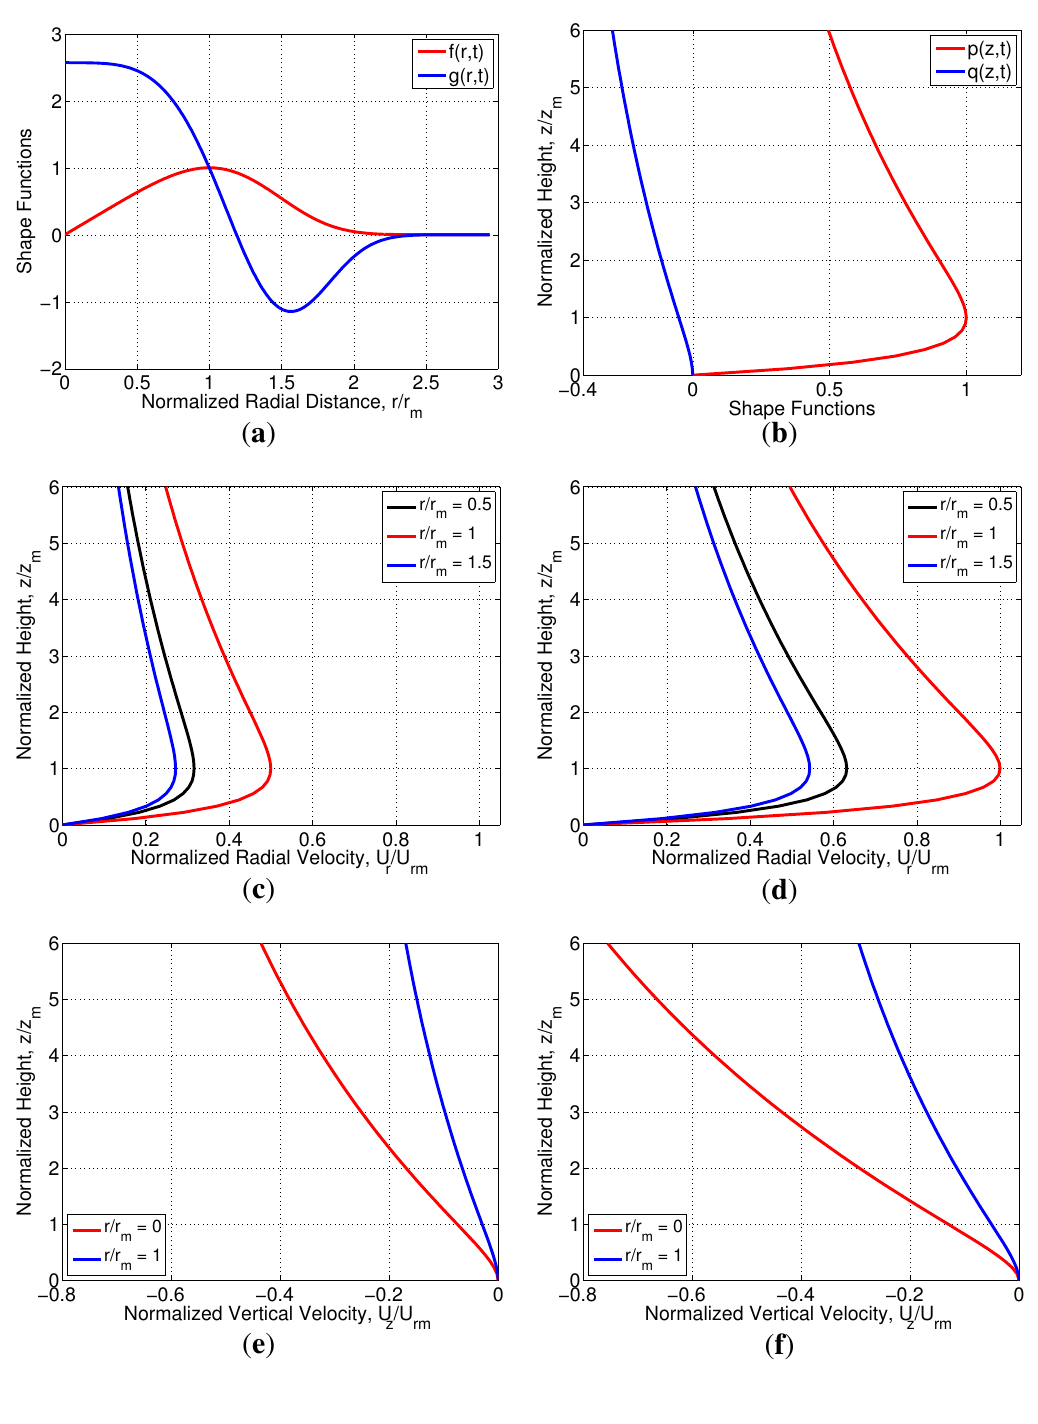
Figure 1. Non-turbulent mean winds: Shape functions and velocity profiles. ( a ) Shape functions for variation of the non-turbulent (mean) wind field with radial distance; ( b ) Shape functions for variation of the non-turbulent (mean) wind field with elevation; ( c ) Non-turbulent radial wind velocity profile when storm intensity, Π( t ) = 0 . 5 , i.e. , t = t / 6 ; ( d ) Non-turbulent radial wind velocity profile when storm intensity, Π( t ) = 1 . 0 , d i.e. , t = t / 2 ; ( e ) Non-turbulent vertical wind velocity profile when storm intensity, d Π( t ) = 0 . 5 , i.e. , t = t / 6 ; ( f ) Non-turbulent vertical wind velocity profile when storm d / 2 intensity, Π( t ) = 1 . 0 , i.e. , t = t d